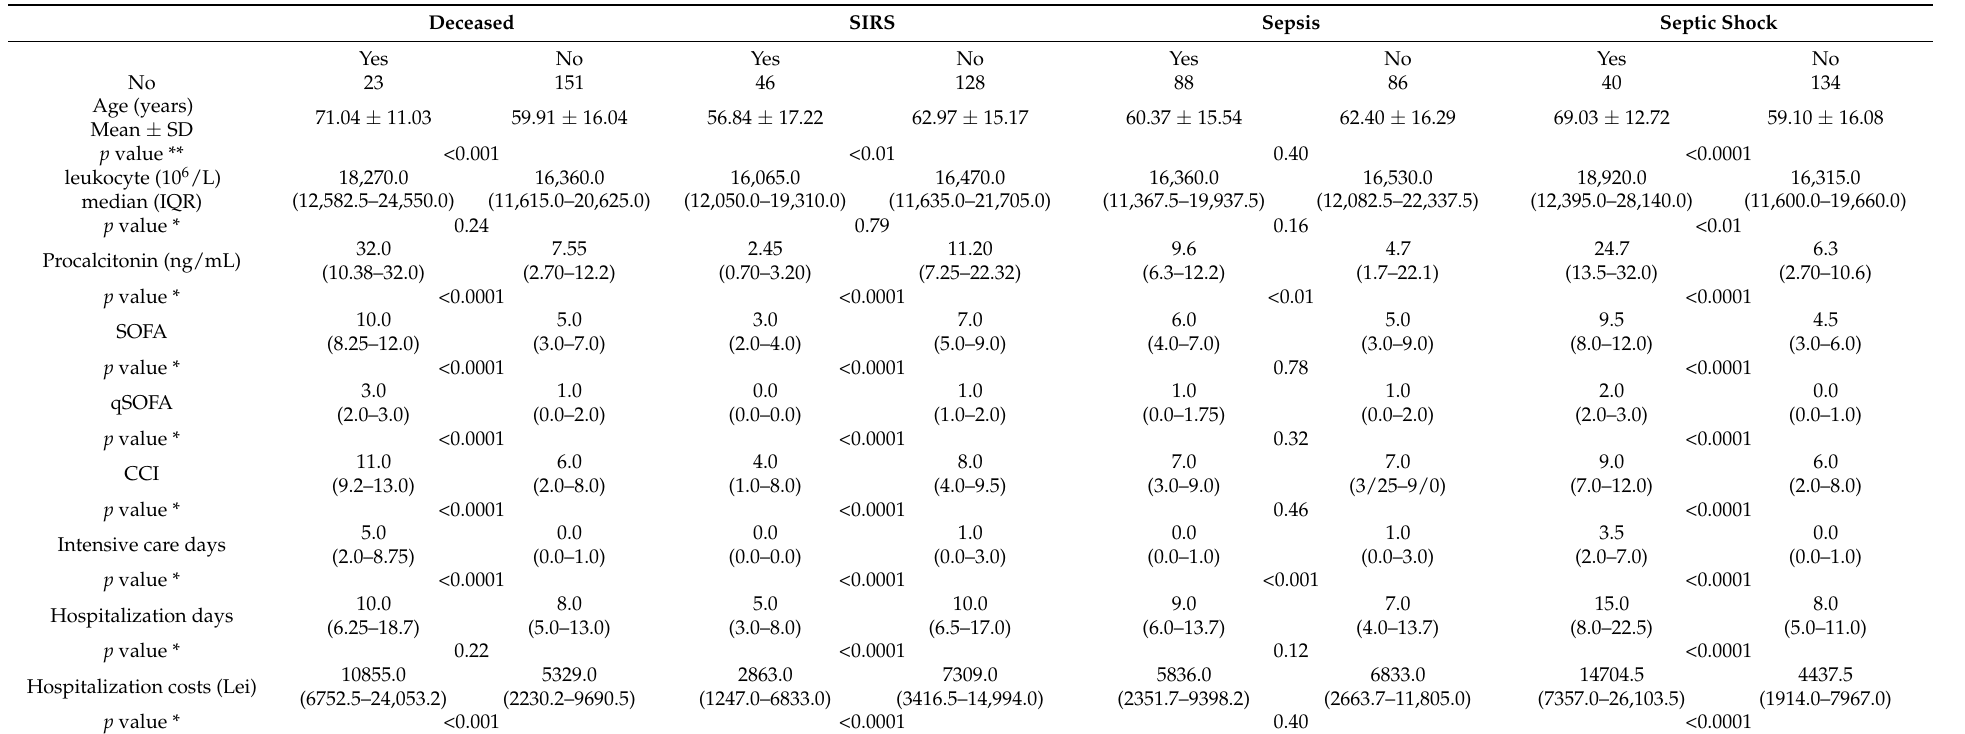
Table 1. Bivariate analysis of variables according to studied